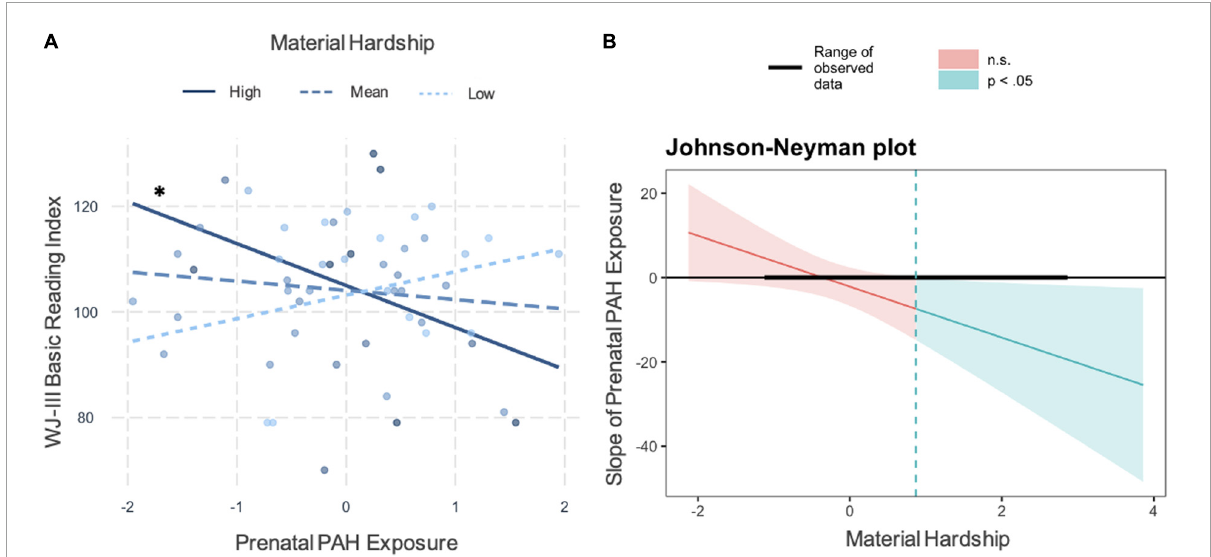
FIGURE1 Interaction plot showing prenatal PAH by material hardship predicting WJ-III Basic Reading Index. (A) The prenatal PAH by material hardship interaction associated with lower Basic Reading Index at child age 7. Higher PAH associated with lower Basic Reading Index scores at higher levels of material hardship (mean ± 1SD), ∗ p < 0.05. (B) Johnson–Neyman plot showing the slope of the association between prenatal PAH and Basic Reading Index at age 7 ( y -axis). PAH was z-scored here ( M = –0.05, SD = 0.90) so the slope can be interpreted as a 1 SD increase in PAH is associated with a Y unit change in Basic Reading Index scores. The observed range of material hardship z-scores was –1.10, 2.83 which is noted in black by the bold line at y = 0. The region of significance analysis indicates p < 0.05 significant association between prenatal PAH and Basic Reading Index in the shaded blue region, (no significant associations in the red, at values of material hardship between –3.18, 0.87). ∗ represents a significant slope.